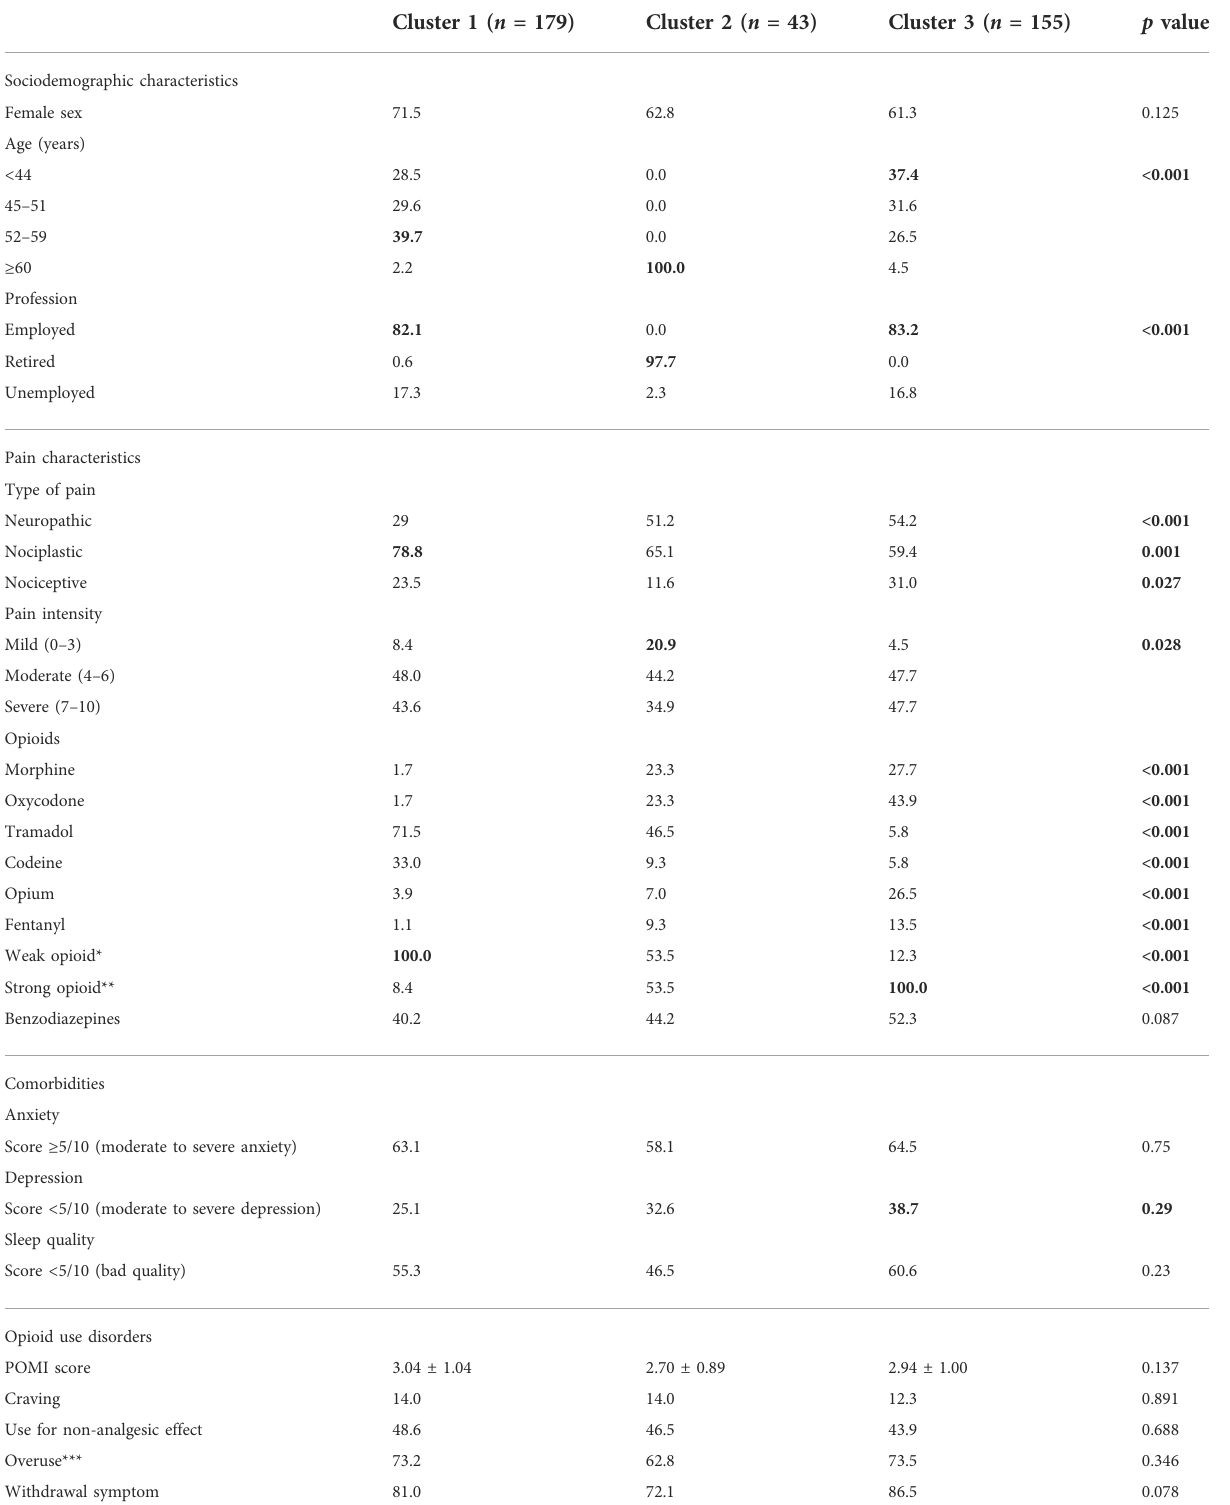
TABLE 4 Characteristics and comparison of subgroups of misusers (cluster